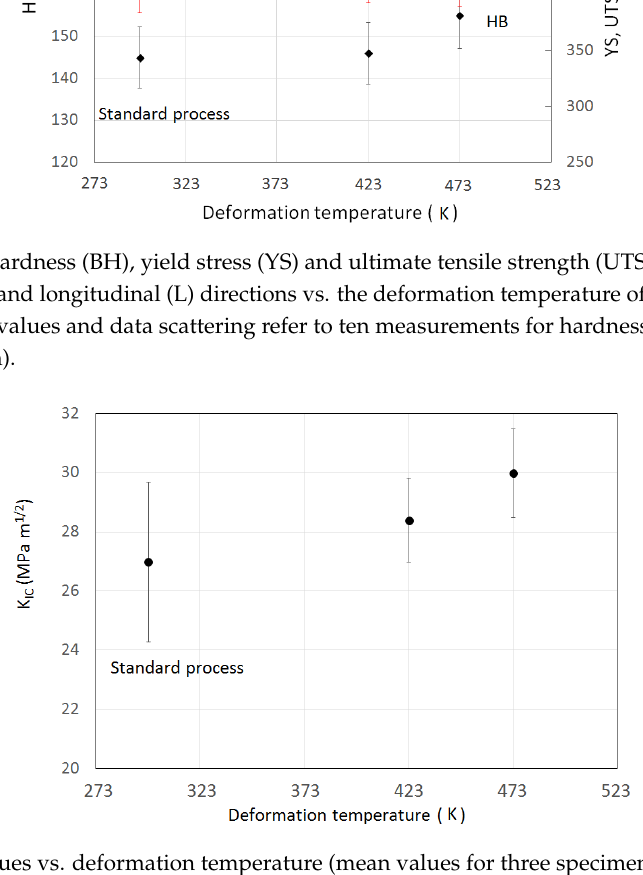
Figure 3. KIC values vs. deformation temperature (mean values for three specimens per condition).